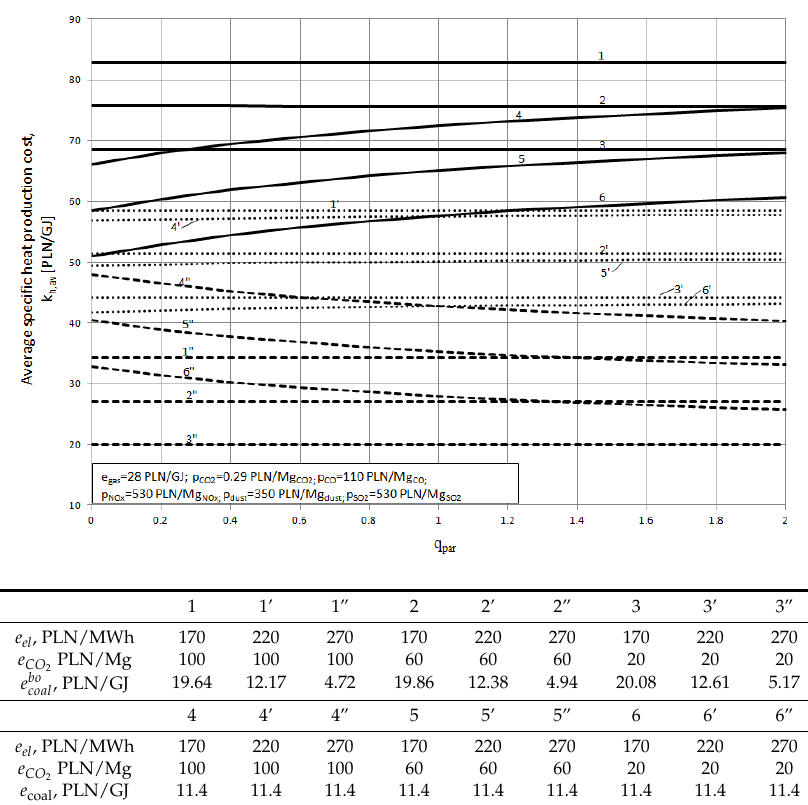
Figure 9. Average specific cost of heat production as a function of q par with the price of coal as a parameter. Energies 2018 , 11 , 1784